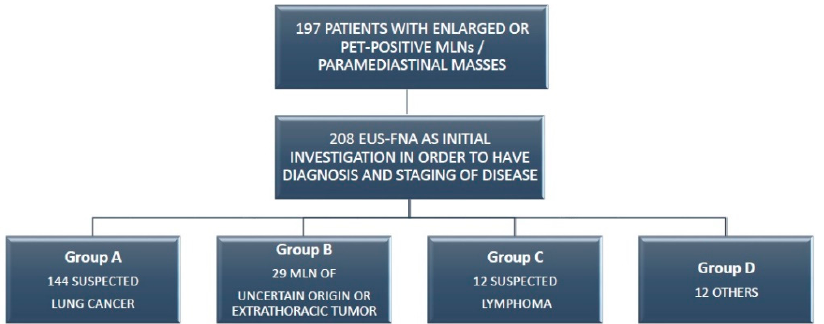
Figure 2. Distribution of patients in which EUS-FNA was performed according to suspected or previous pathology.